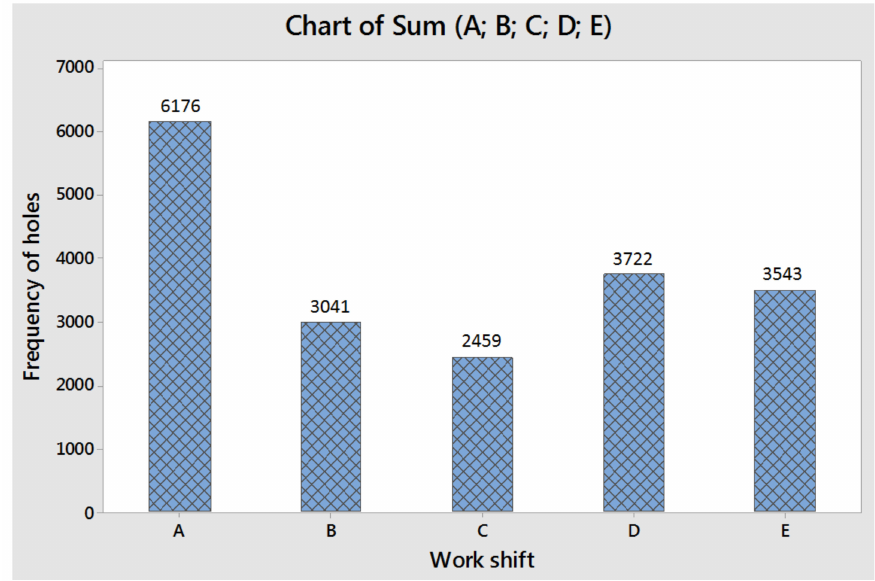
Figure 5. Occurrence of holes according to work shifts. Source: own